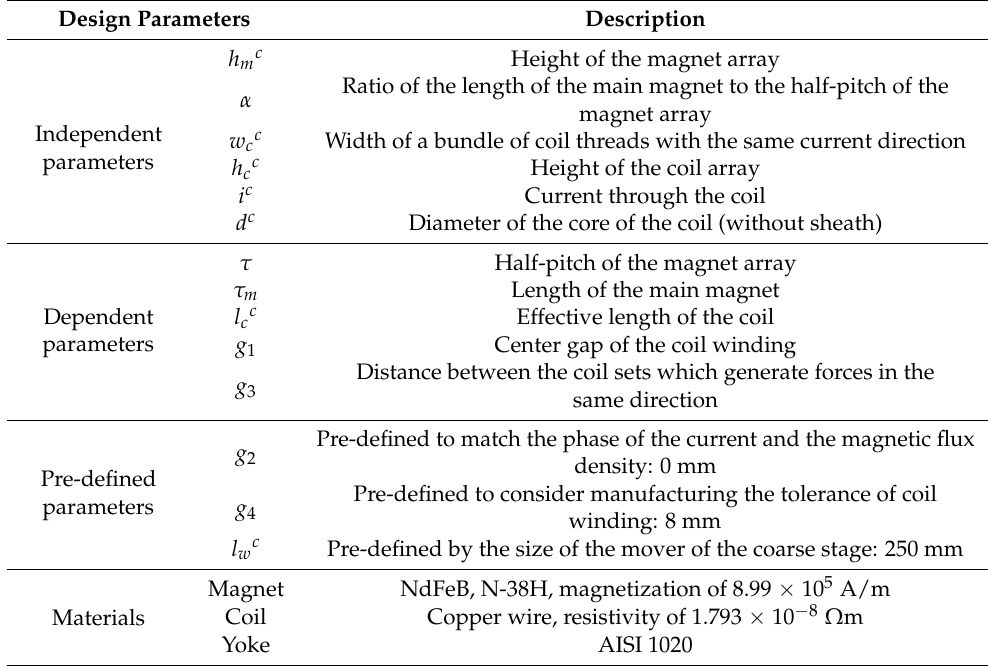
Figure 4. Design parameters of the planar motor, ( a ) magnet array, ( b ) coil array, and ( c ) four sets of 3-phase coils. Table 2. Design parameters of the planar